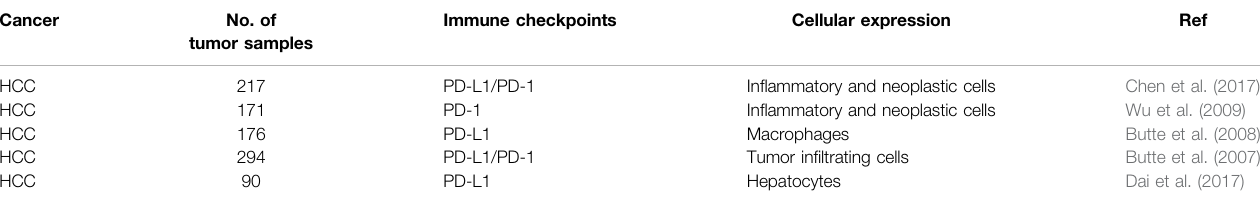
TABLE 1 | The expression of PD-1 immune checkpoints in liver